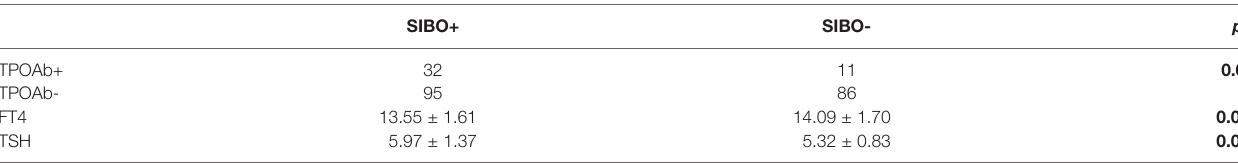
Boldface indicates statistical signi fi